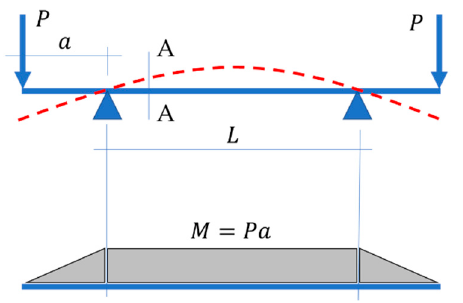
Figure 1. 4-point bending test.